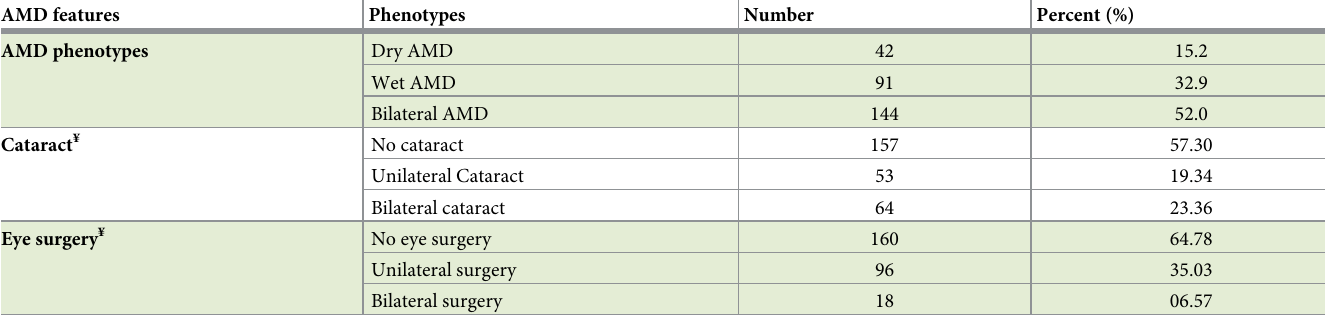
Table 3. Clinical characteristics of North-West Indian AMD recruited in the study. AMD